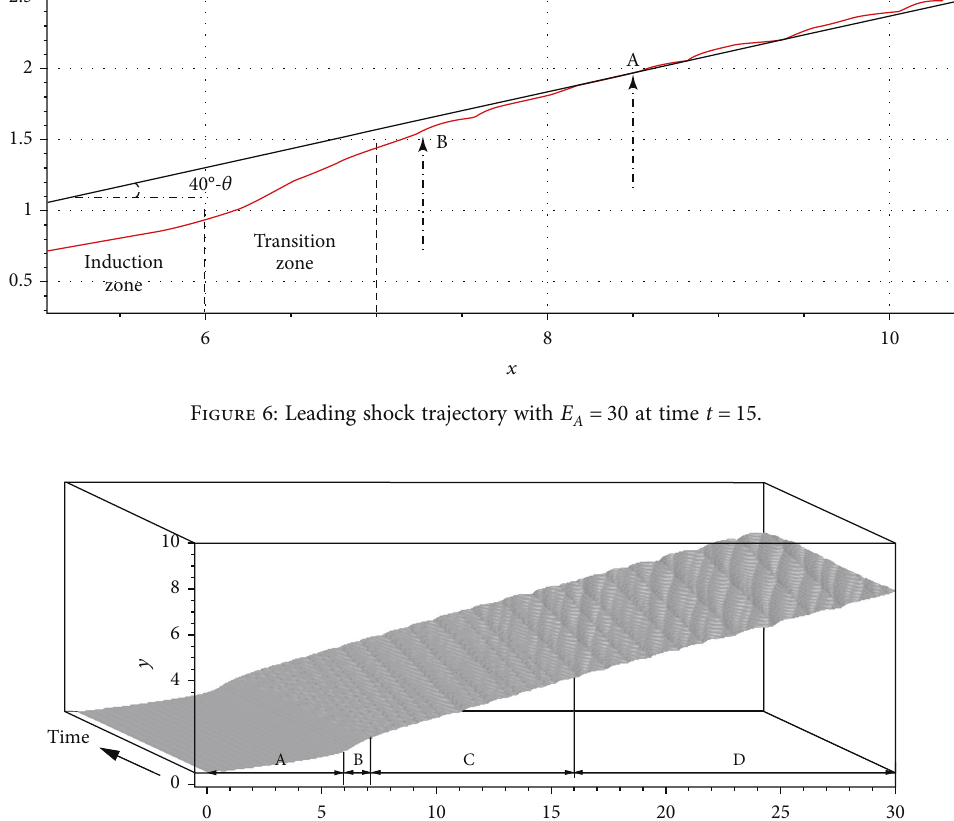
= 30 at time t = 15 . A